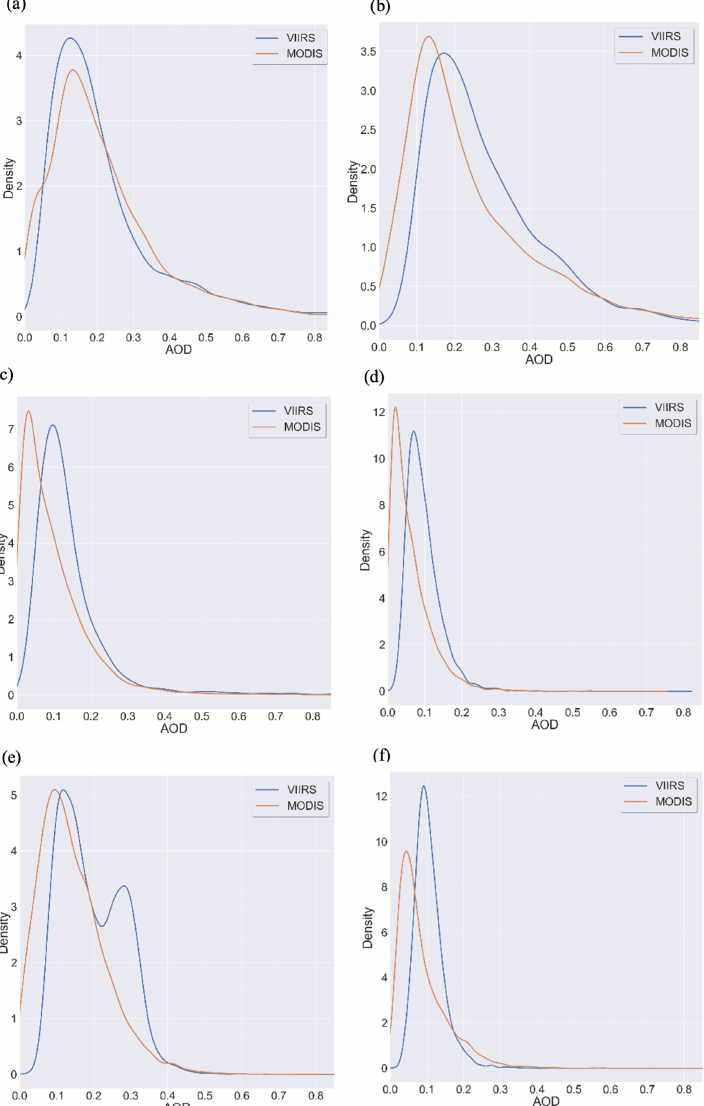
Figure C2. AOD distributions over distinct land regional domains for the DJF period. (a) Africa, (b) Asia, (c) Australia, (d) North America, (e) South America, and (f)